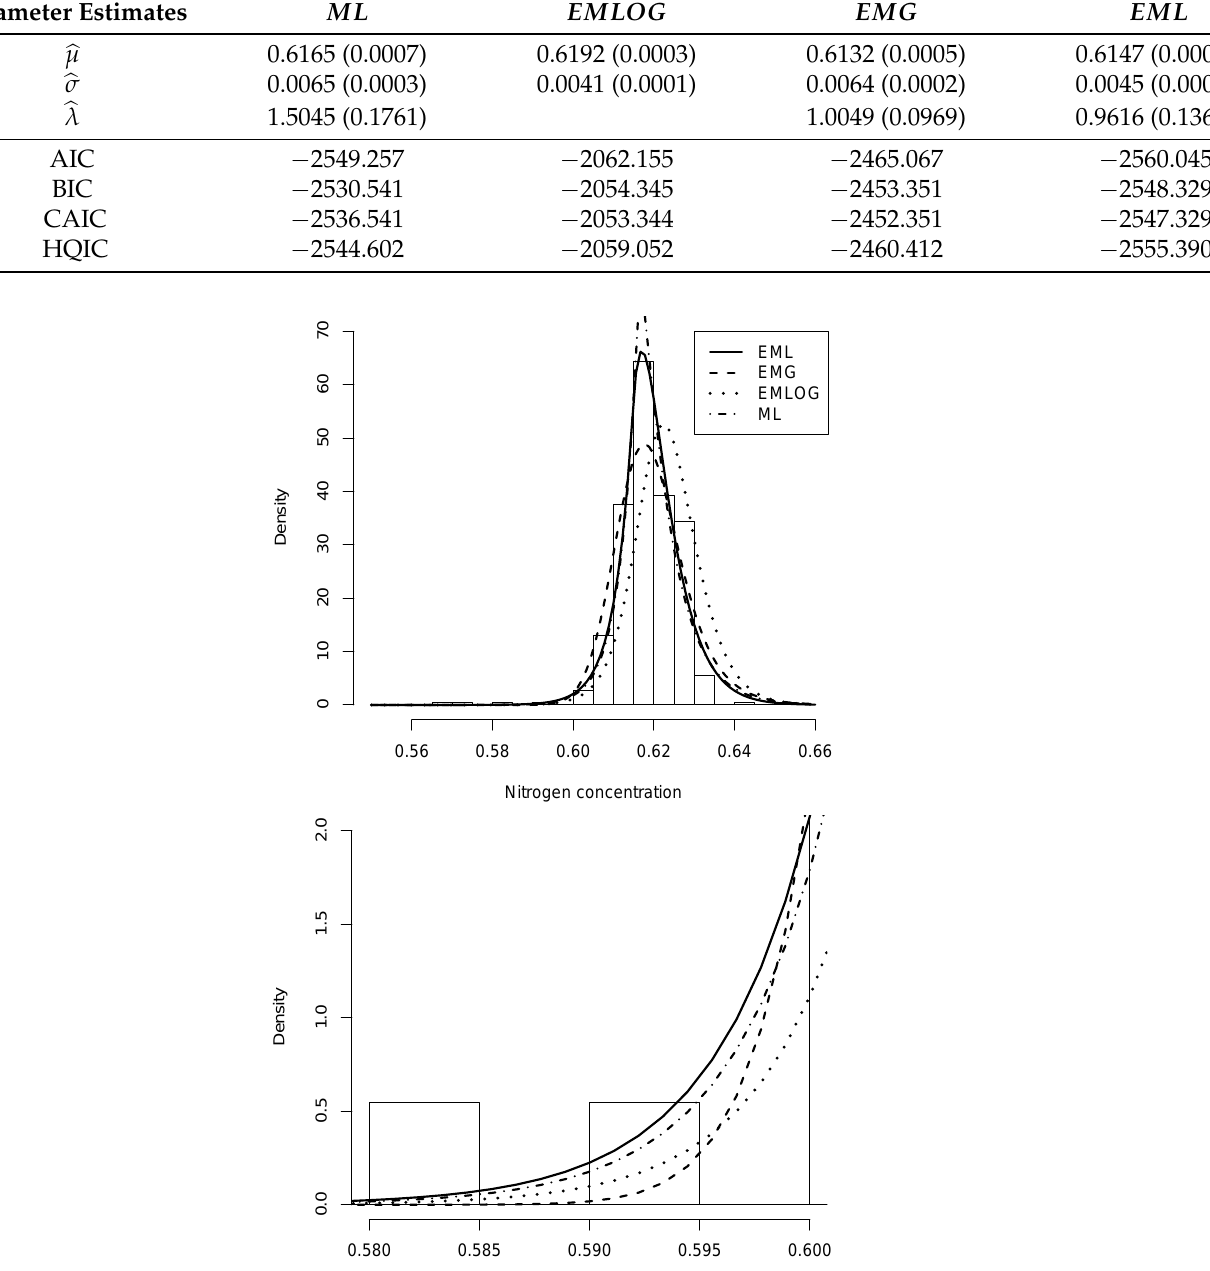
Figure 9. Histogram ( upper ) and tail ( lower ) for nitrogen concentration data set. The first graph shows the densities of exponentially modified Laplace (solid line), Gaussian modified exponentially (dashed line), exponentially modified logistic (dotted line) and modified Laplace (dash-dotted line) distributions, with their parameters estimated by